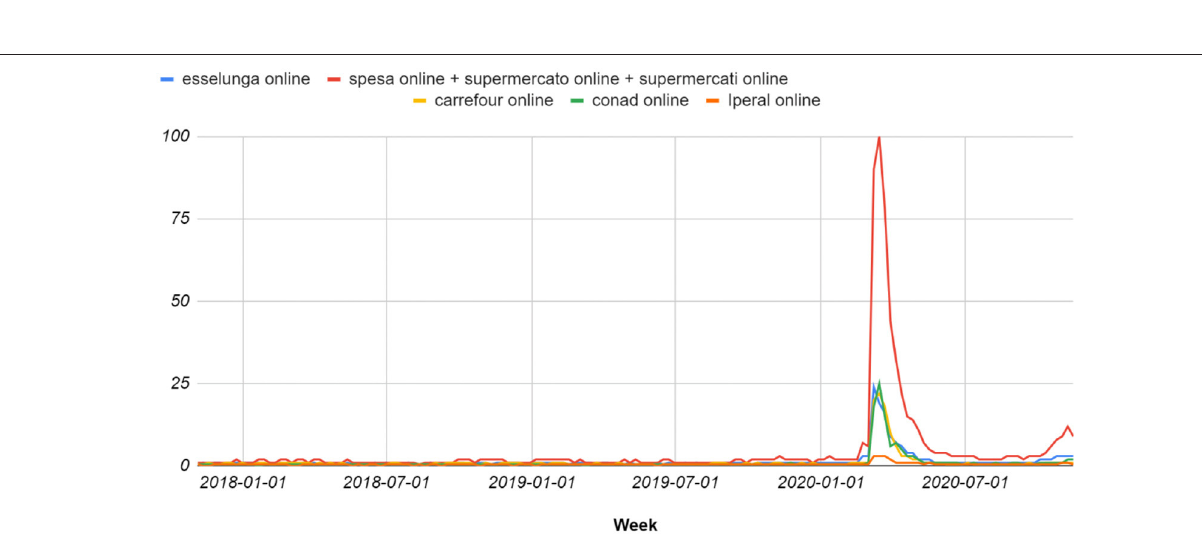
FIGURE 2 | Italian citizens’ web interest in supermarket delivery services from November 2017 to November 2020.